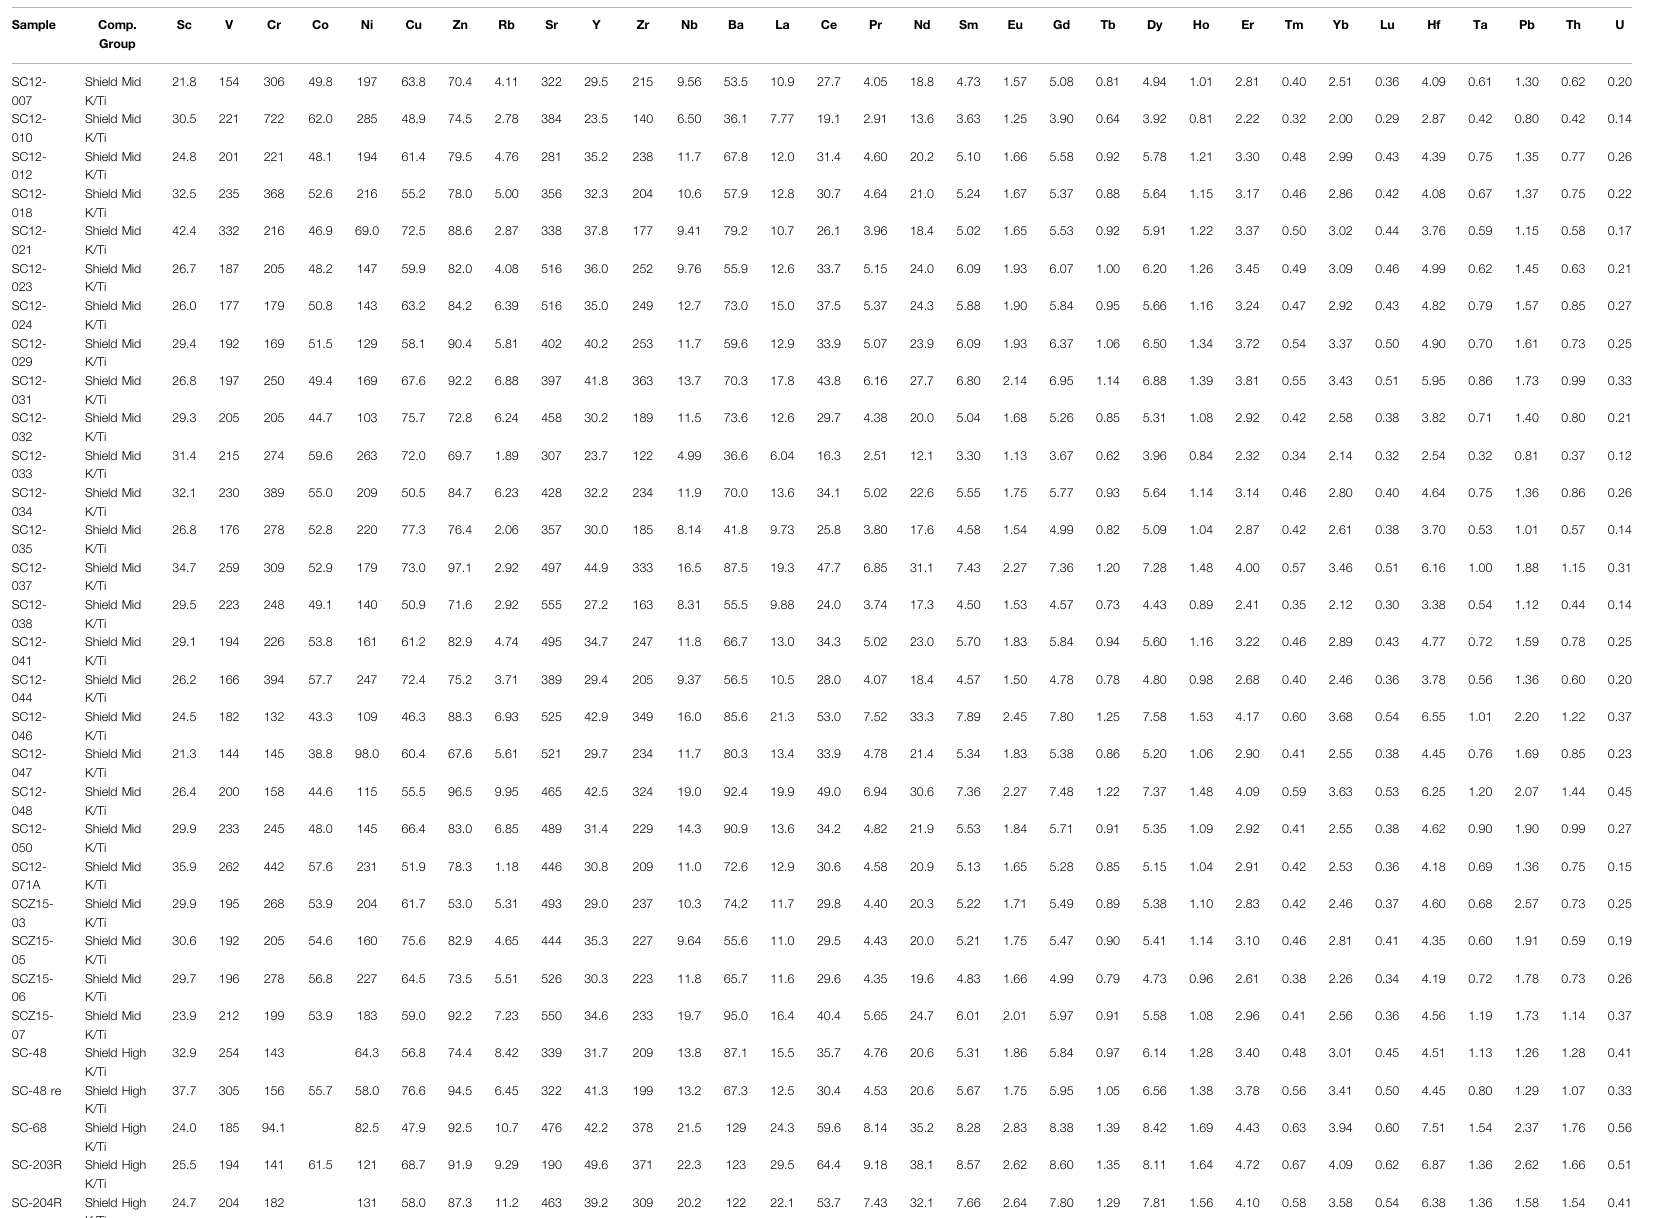
TABLE 2 | ( Continued ) Trace element abundances of Santa Cruz lavas, reported in parts per million (ppm). One replicate analysis (indicated by “ re ” ) is